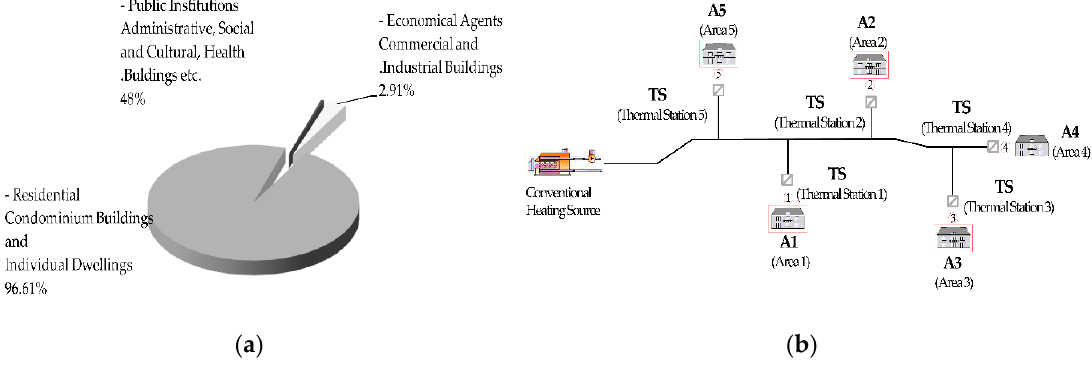
Figure 2. ( a ) Typology of thermal consumers—buildings, in the reference locality [42]; ( b ) Simplified scheme of the district heating system within Case Study [42].